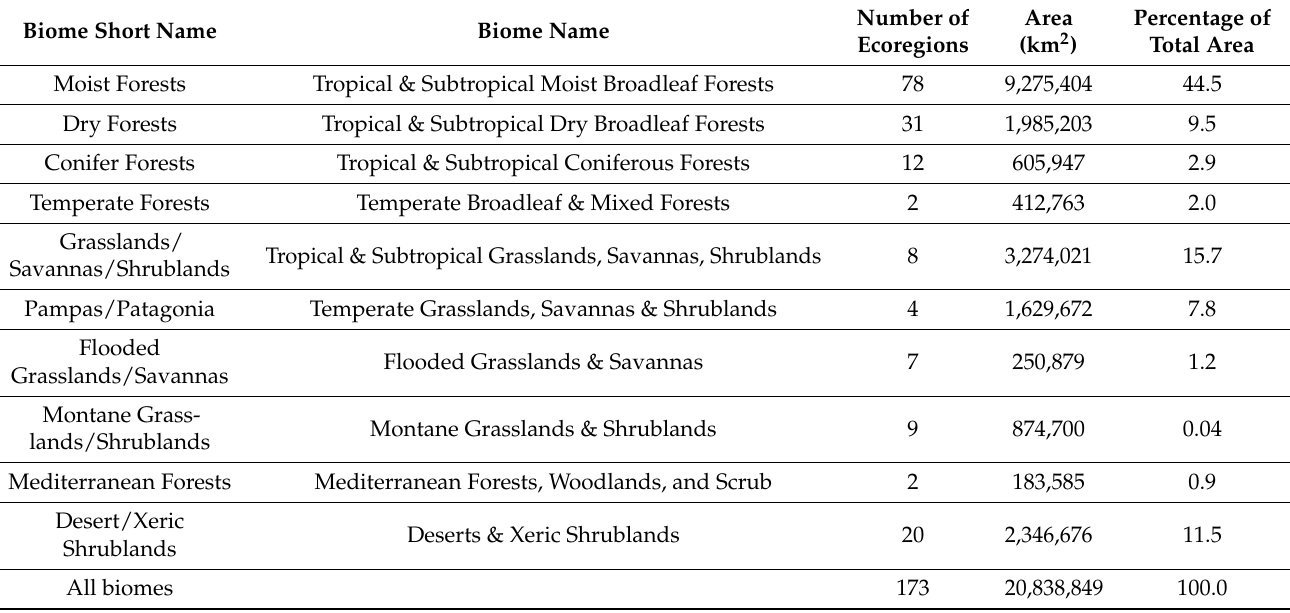
Table 1. Biome abbreviated name, biome name, number of ecoregions, and